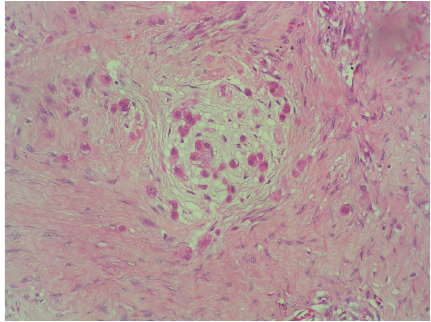
Figure 2: Histopathologic image showing how cells are arranged in a series of nidi, separated by abundant collagen